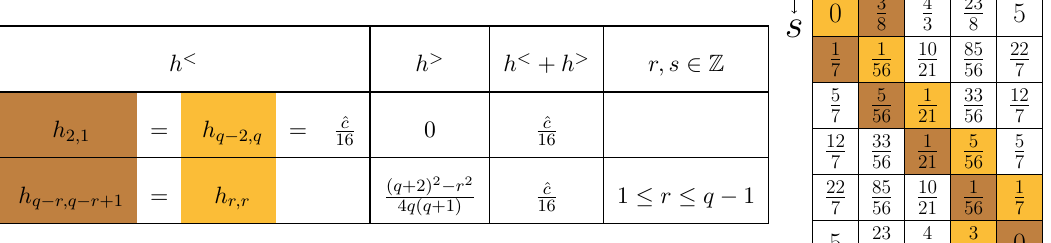
Table 1 . Ramond ground states in SW ^ c coloured the corresponding cells in the Kac table for q =